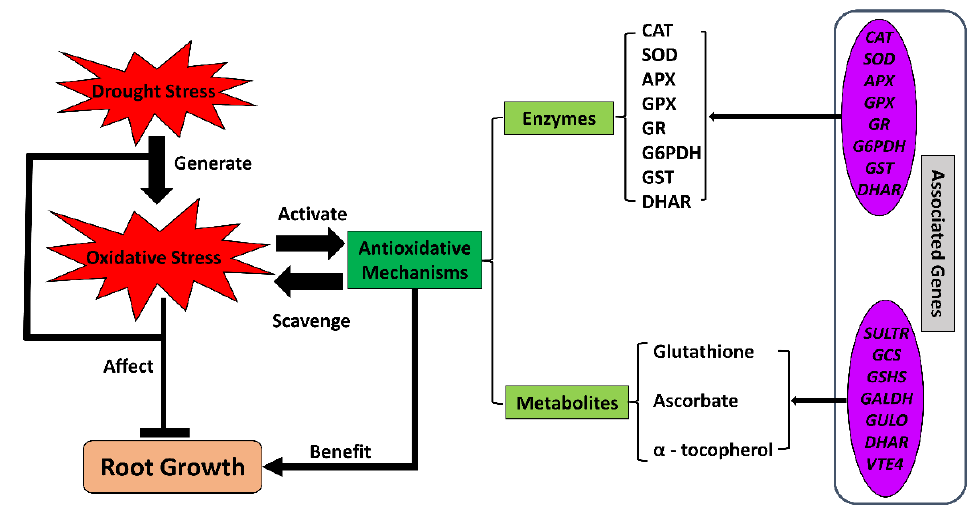
Figure 4. The antioxidative system under drought conditions in crop roots. Drought stress limits root growth while generating oxidative stress. Antioxidative mechanisms, including enzymes and non-enzymatic metabolites, respond to the oxidative stress by regulating the expression of a wide range of related genes. The activated antioxidative system scavenges the oxidative radicals and restores cellular homeostasis. APX, ascorbate peroxidase; CAT, catalase; DHAR, dehydroascorbate reductase; SOD, superoxide dismutase; G6PDH, glucose-6-phosphate dehydrogenase; GALDH , L-galactose dehydrogenase gene; GCS , gamma-glutamylcysteine synthetase gene; GPX, glutathione peroxidase; GR, glutathione reductase; GSHS , glutathione synthase gene; GST, glutathione S-transferase; GULO , L-gulonolactone oxidase gene; SULTR , sulfate transporter; VTE4 , gamma-tocopherol methyltransferase gene.